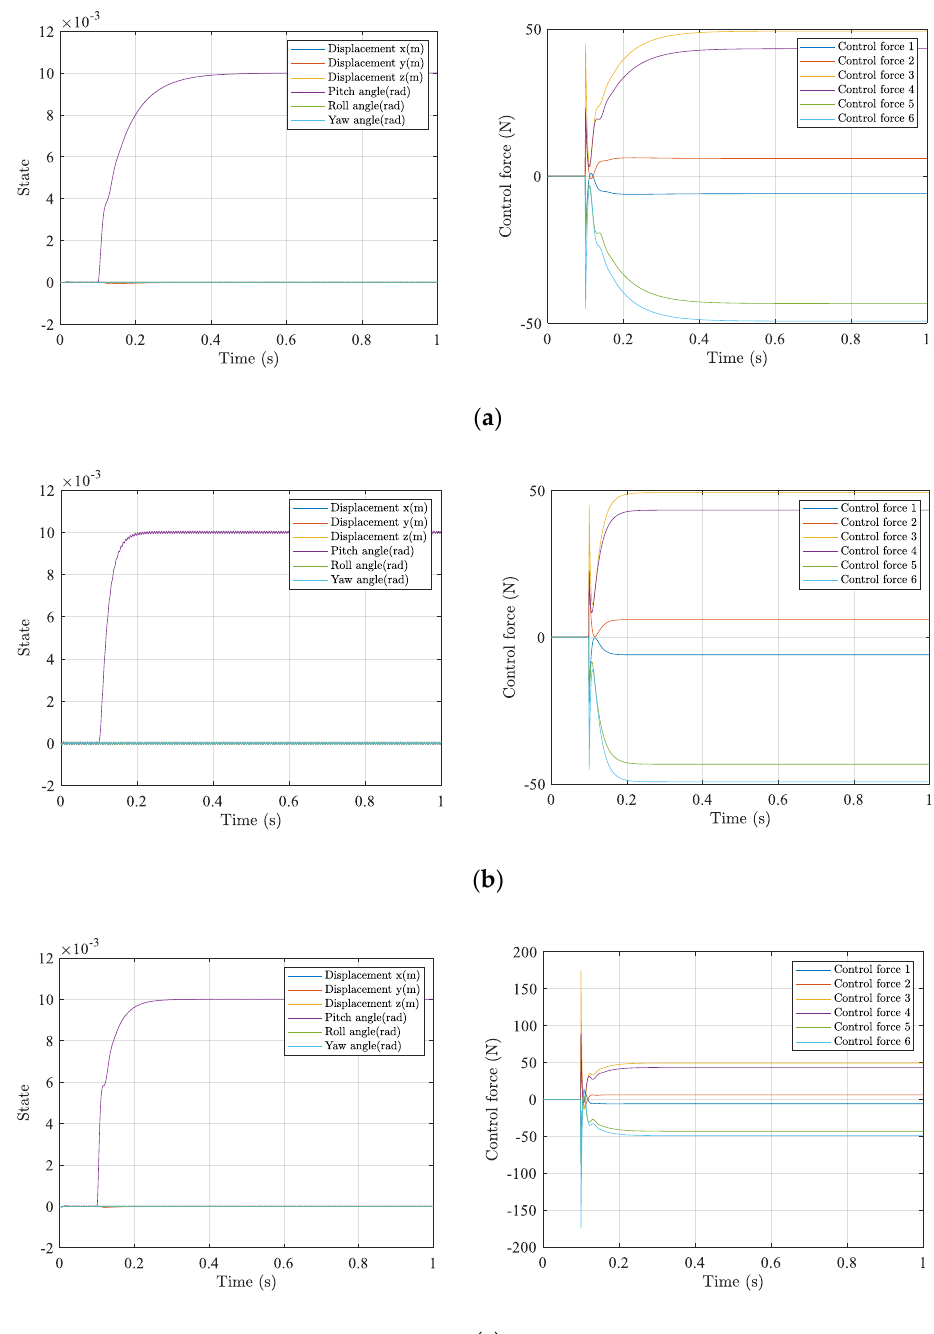
Figure 5. The time history of the pitch angle and control force with different ω o . ( a ) ω o = 200, ω c = 100. ( b ) ω o = 1000, ω c = 100. ( c ) ω o = 200, ω c = ， 200